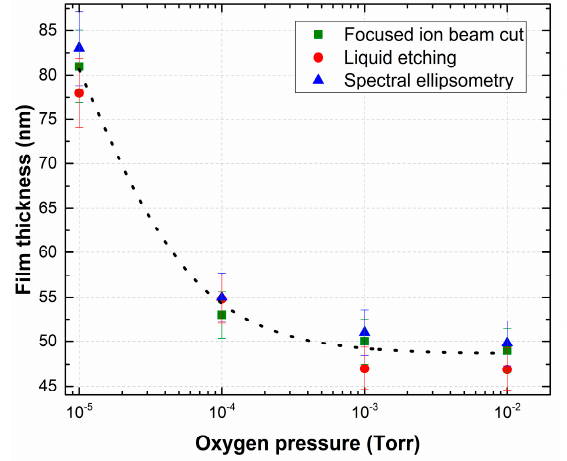
Figure 3. Dependence of the thickness of the LiNbO 3 film as a function of oxygen pressure measured by different methods.